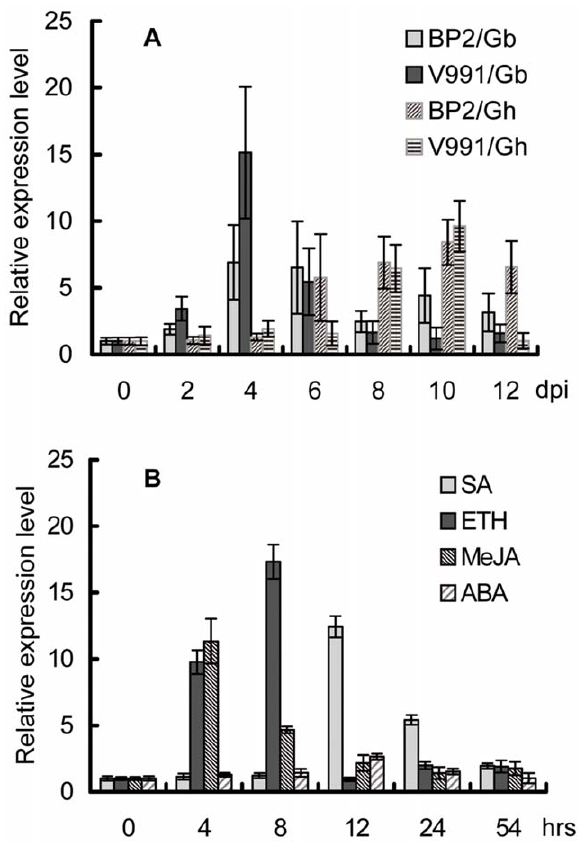
Figure 2. Expression patterns of the Gbve1 and Ghve1 genes. (A). Expression patterns of Gbve1 / Ghve1 genes in H7124 (Gb) and Yumian 1 (Gh) under infection by V. dahliae isolate V991 and BP2. dpi means days post inoculation. (B). Expression patterns of the Gbve1 gene by different